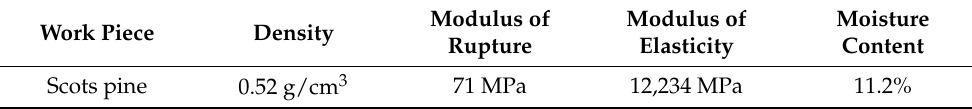
Modulus of Modulus of Moisture Rupture Elasticity Content